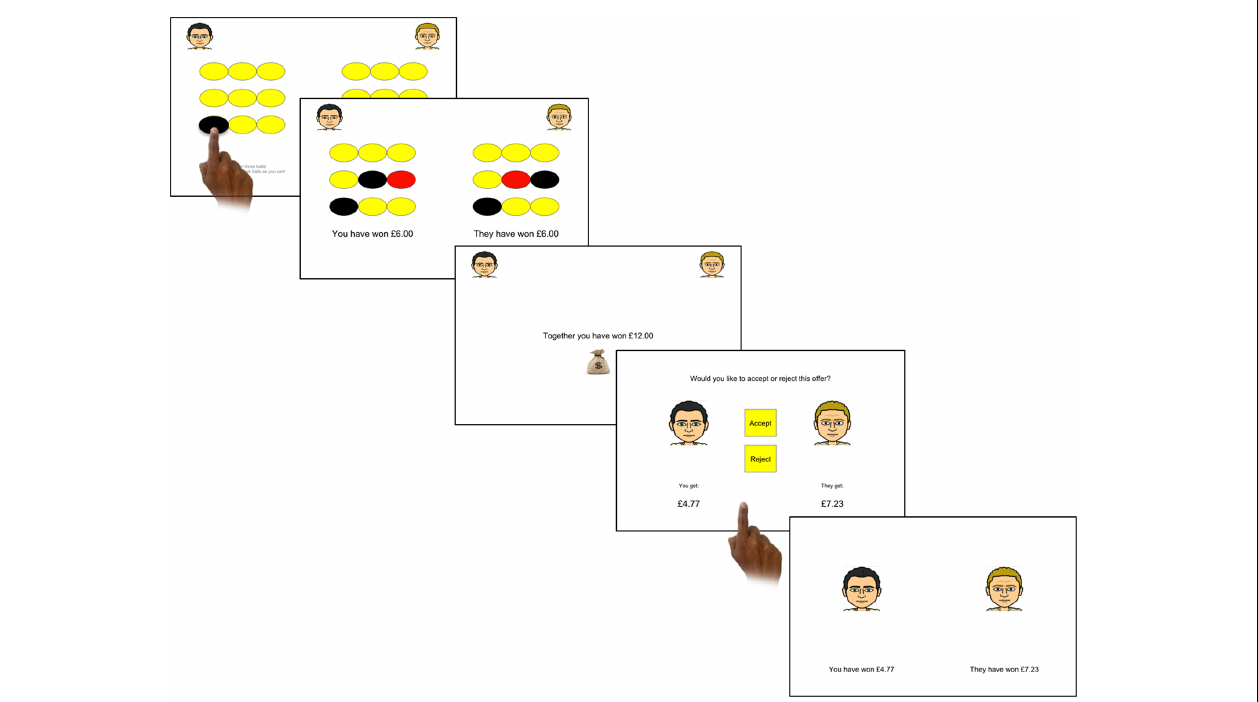
FIGURE 1 | One trial of the Ultimatum Game. First, participants had to select three ovals before receiving feedback of how much they and their computer opponent have contributed. A screen then showed the total of their combined earnings. In this trial the computer decided how the money should be split and the participant chose whether to accept or reject the offer. If the participant accepted, the earnings were distributed accordingly; however, if the participant rejected, neither player received anything. Finally participants were shown feedback of how much they had